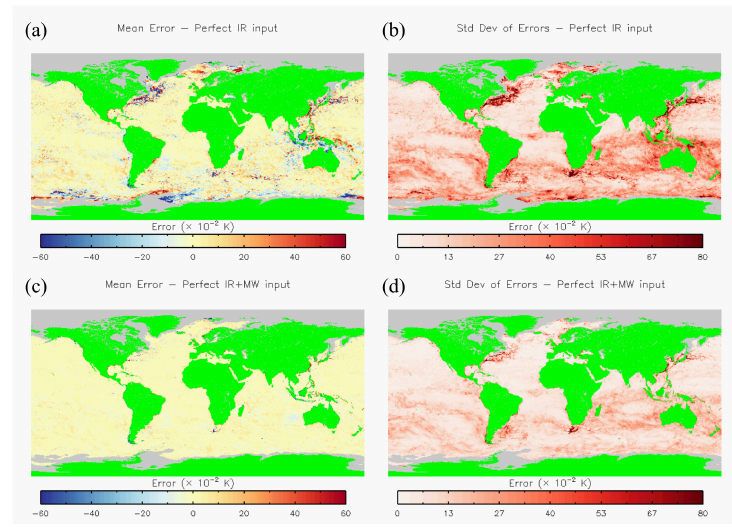
Figure 5. Maps of the January error statistics: ( a ) mean error with perfect IR data only, ( b ) standard deviation of the error with perfect IR data only, ( c ) mean error with combined perfect IR and CIMR data and ( d ) standard deviation of the error with combined perfect IR and CIMR data.